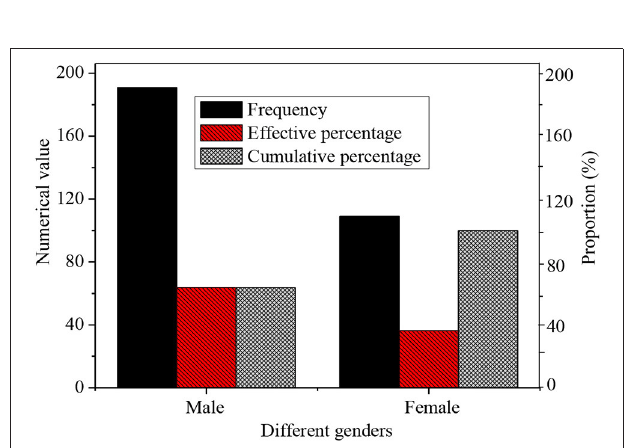
FIGURE 5 | Nature of the new ventures and the positions of the interviewees ( A . Nature; 1. A metallurgical company; 2. A construction company; 3. A software company; 4. A food company; 5. A biomedical company; 6. An energy and raw materials company; 7. A clothing company; 8. A water conservancy company; B . The positions of interviewees; a. Corporate executives; b. Salesmen; c. Production personnel; d. R and D personnel; e. After-sale employees).